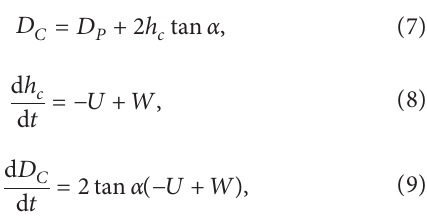
Figure 2: Simplified one-dimensional model of a bullet impacting a ceramic-metal plate during the first